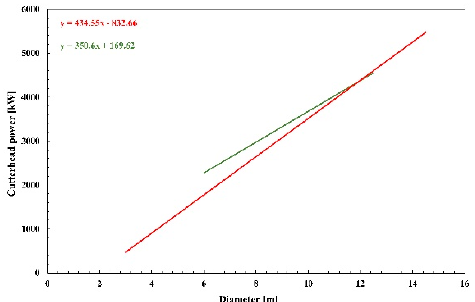
Figure 20. Trend of the power vs. the diameter based on data collected from the analysis of open TBMs. In red, the experimental model proposed in this study; in green, the model proposed by [43].